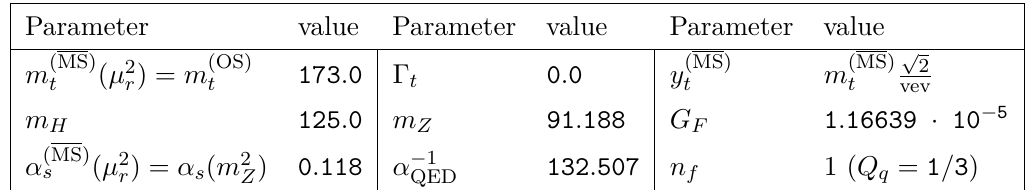
Table 1. Common SM parameters used for obtaining all numerical results presented in section 6. Dimensionful parameters are given in GeV. Notice that for simplicity, α ( MS ) running are disabled for the demonstrative results of this